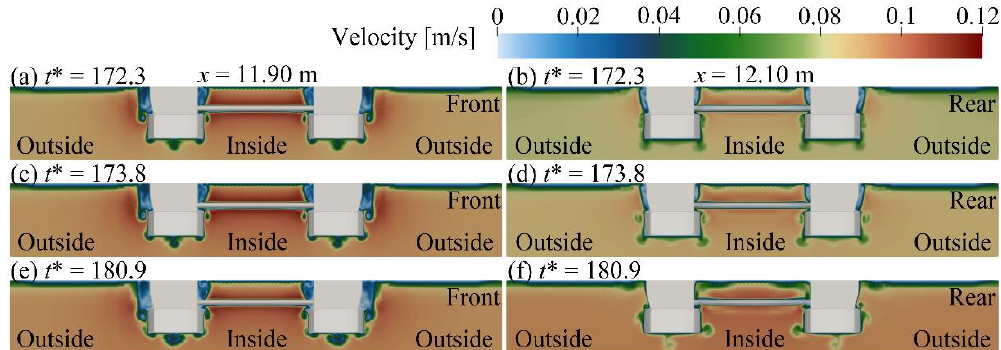
Figure A2. Velocity around the platform at x = 11.90 m and x = 12.10 m for Case A2.